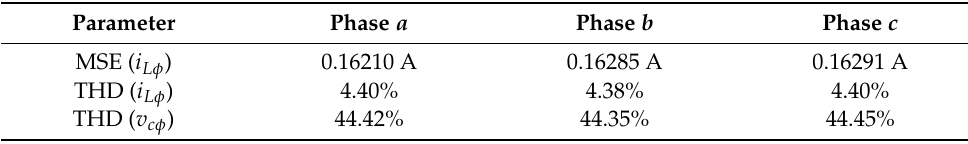
Table 7. Simulation results for PI in steady-state